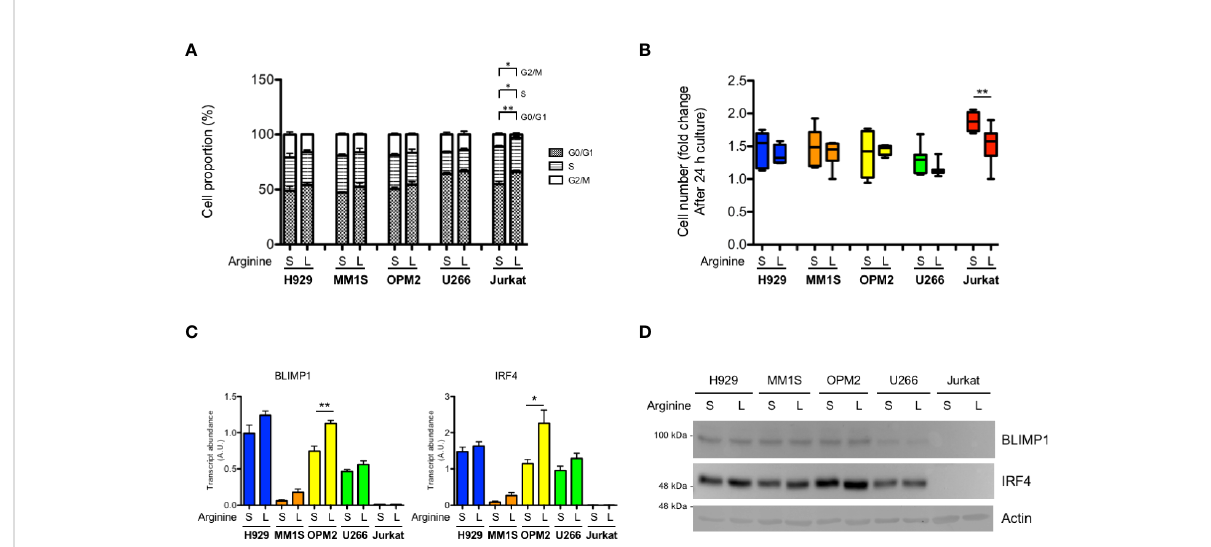
FIGURE 1 Differential sensitivity of T lymphocytes and myeloma cells to arginine depletion. MM cell lines (H929, MM1S, OPM2, U266) and immortalized human T lymphocytes (Jurkat) were cultured for 24 hours (h) in complete medium containing standard (S, 1140 µM) or low (L, 11 µM) arginine concentration. (A) Cell cycle distribution was analyzed by fl ow cytometry and the percentage of cells in the indicated phases are represented (n = 3 independent experiments). *p<0.05, **p<0.01, paired t -test. (B) Box and whiskers plot representing relative cell proliferation of the indicated cell lines in different arginine concentration for 24 h (n ≥ 6 experiments). **p<0.01, paired t -test. (C) Relative abundance of transcripts encoding BLIMP1 and IRF4 (A.U., arbitrary units; n ≥ 3 independent experiments). Bars indicate average ± s.e.m. *p<0.05, **p<0.01, unpaired t-test. (D) Representative immunoblot analysis showing the effect of 24 h arginine shortage on the protein abundance of the PC master factors BLIMP1 and IRF4 in MM cell lines. Actin B serves as loading